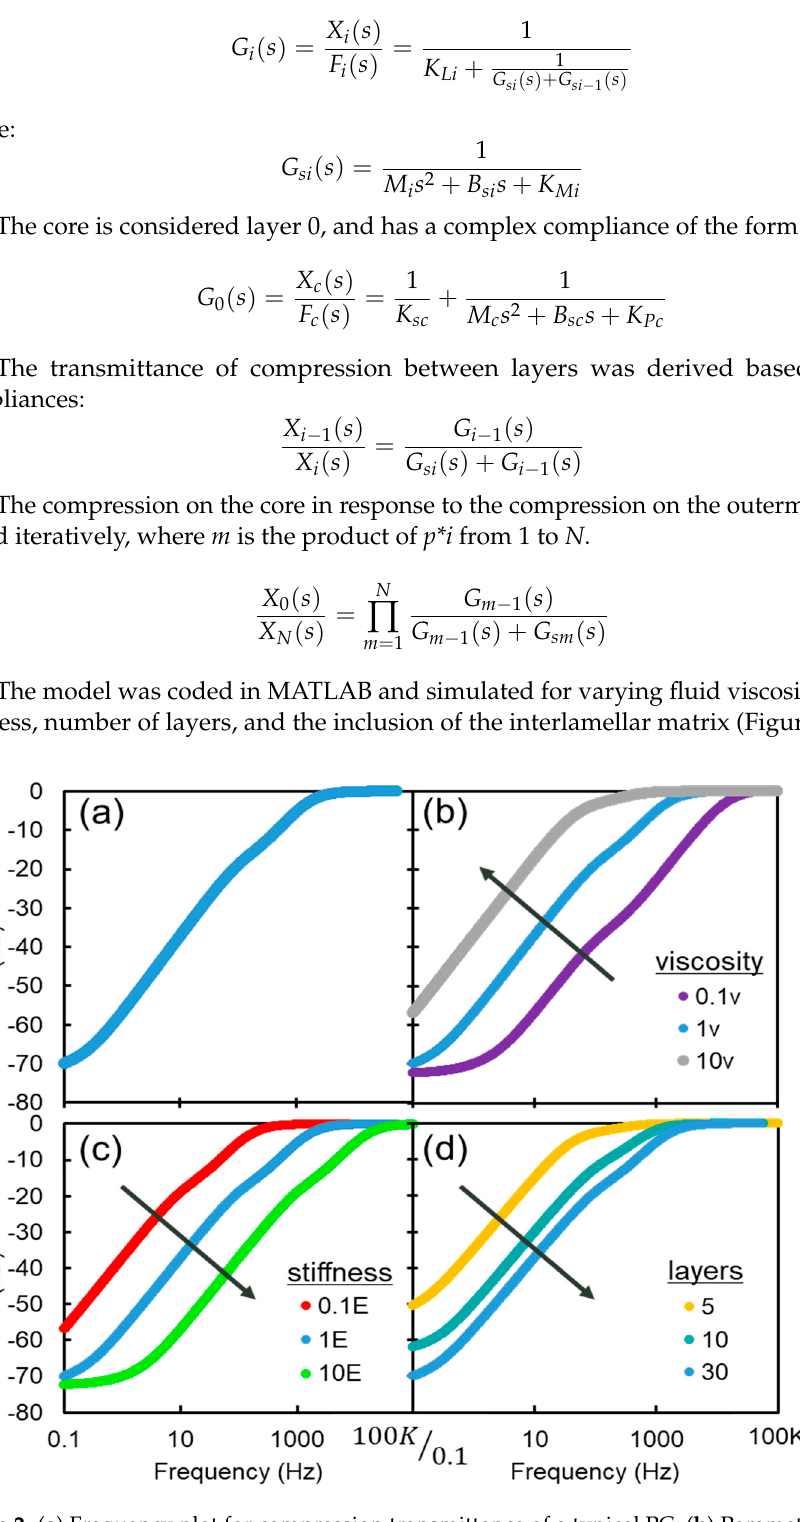
Figure 2. ( a ) Frequency plot for compression transmittance of a typical PC; ( b ) Parametric sweep of viscosity; ( c ) Parametric sweep of Young’s modulus; ( d ) Parametric sweep of number of